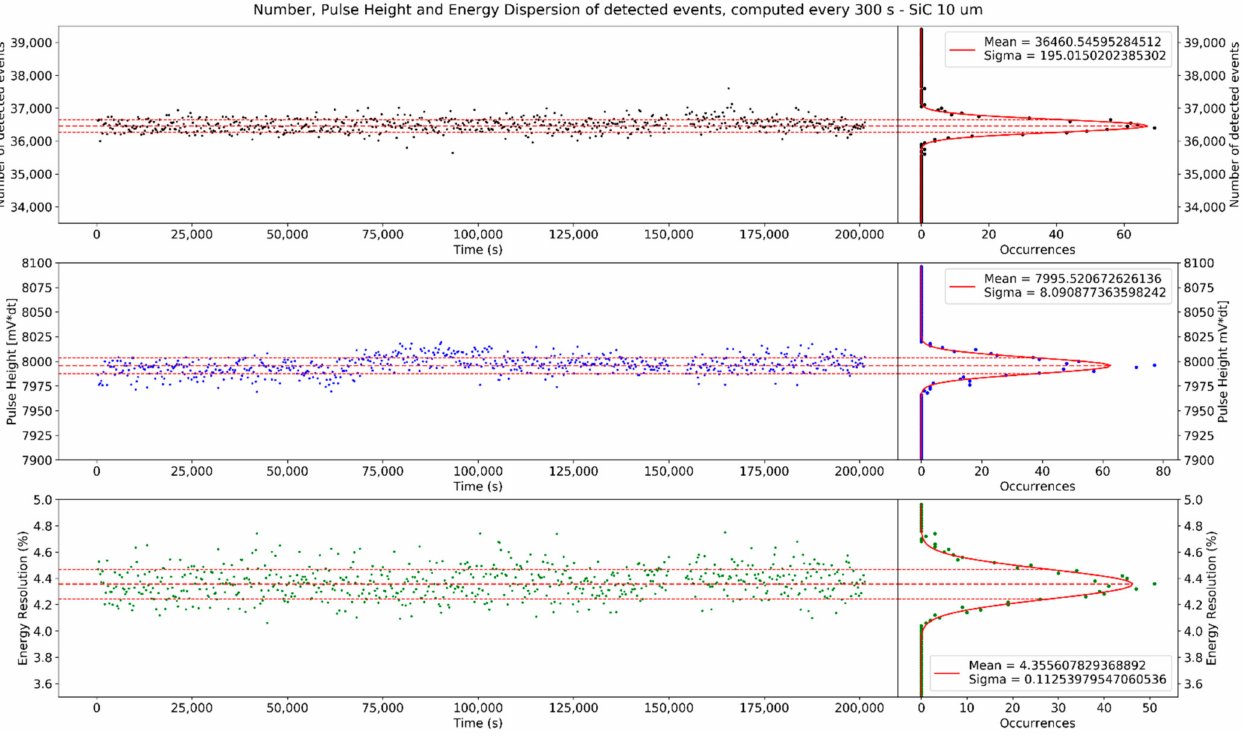
Figure 2. Pulse height distribution for a 300 s exposure of the SiC10 to 4.7 MeV α particles (black line), fitted with a Gaussian function (red line), obtaining a mean pulse height of 7986.34. FWHM is 386.94, which provided an energy resolution of